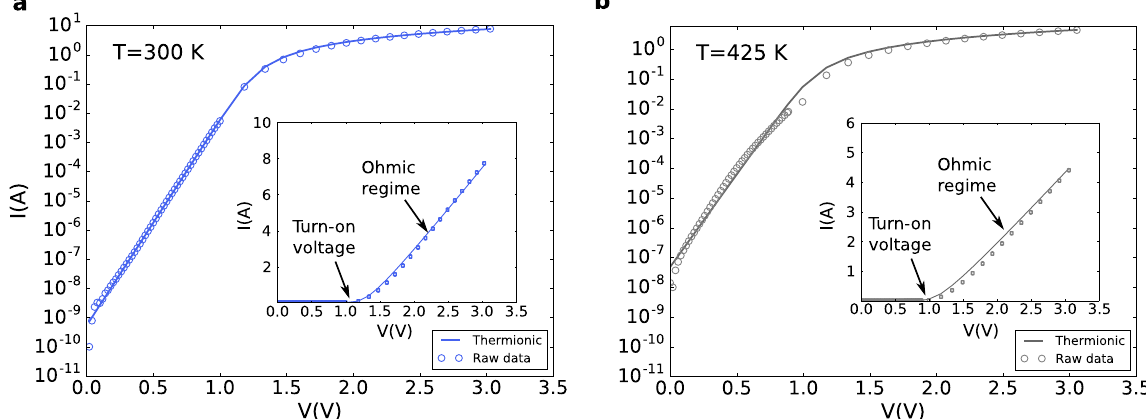
Figure 6. Thermionic fit at various temperatures. ( a ) Semilog plot of the I(V) on state characteristics of the recessed diode at 300 K fitted using the thermionic formula. Inset : Linear plot showing the ohmic regime above the turn-on voltage. ( b ) 425 K